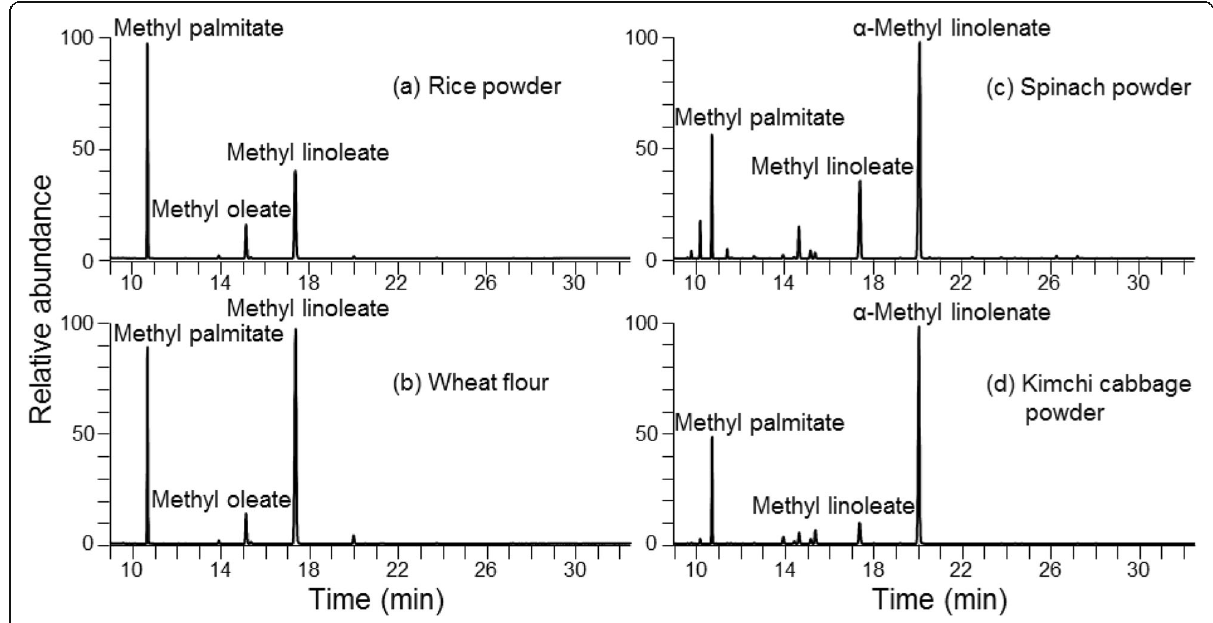
Fig. 1 GC/MS total ion chromatograms of FAMEs in ( a ) rice flour, ( b) wheat flour, ( c ) spinach powder, and ( d ) kimchi cabbage